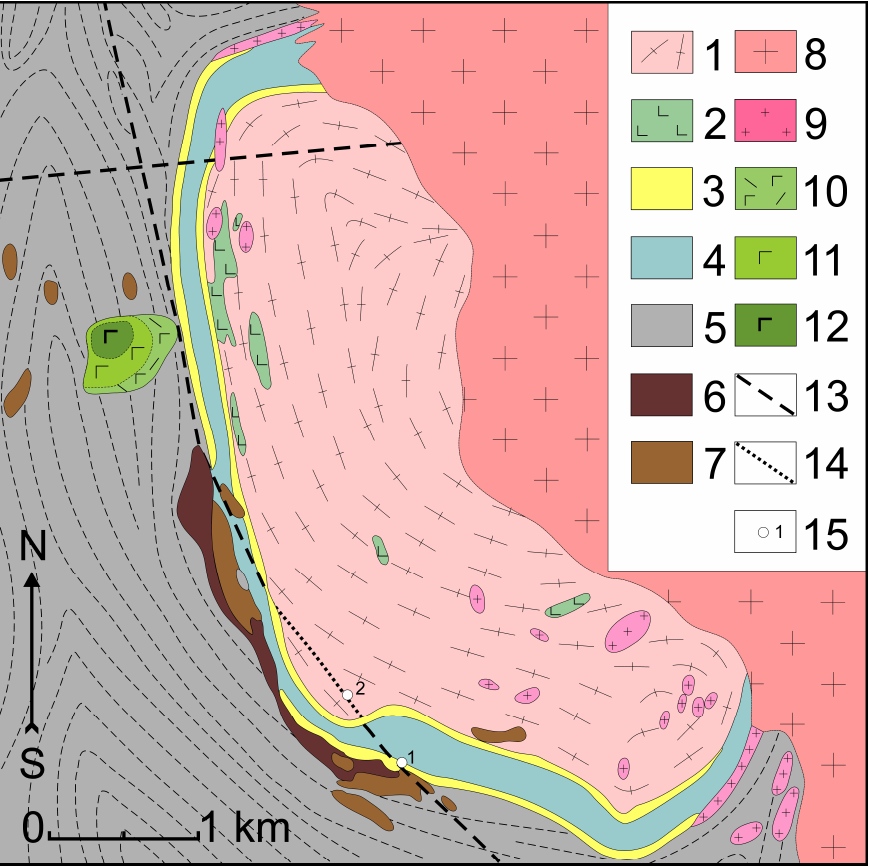
Figure 3. Geological scheme of the Lupikko gneiss-granite dome and its framing, the position of the object under study, compiled by the current author with consideration of the material presented